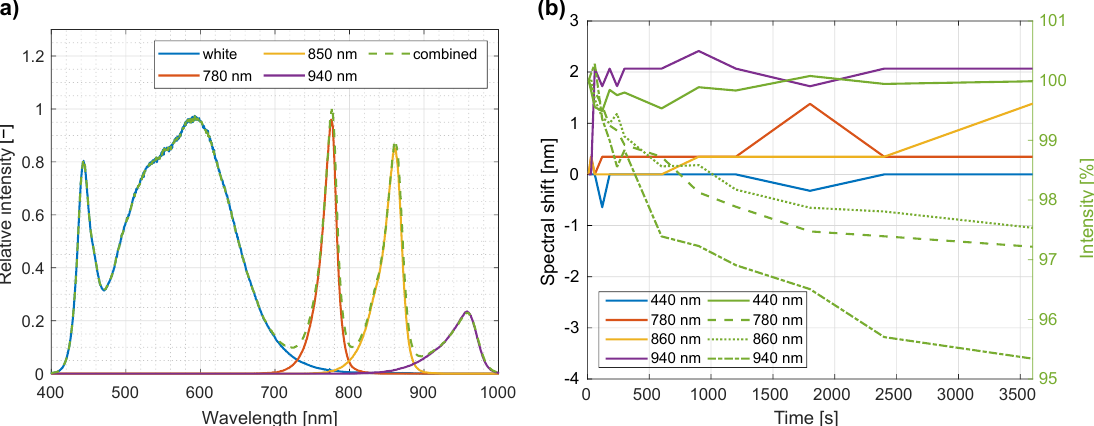
Figure 10. Illumination composition and temporal spectral stability of LED light source. ( a ) Different individual LED spectra along with the complete illumination spectrum. ( b ) Temporal stability in terms of the spectral shift and intensity change at different time intervals compared to the state 10 s after turning the illumination on. To reduce the noise, averaging of 30 measurements for each LED was